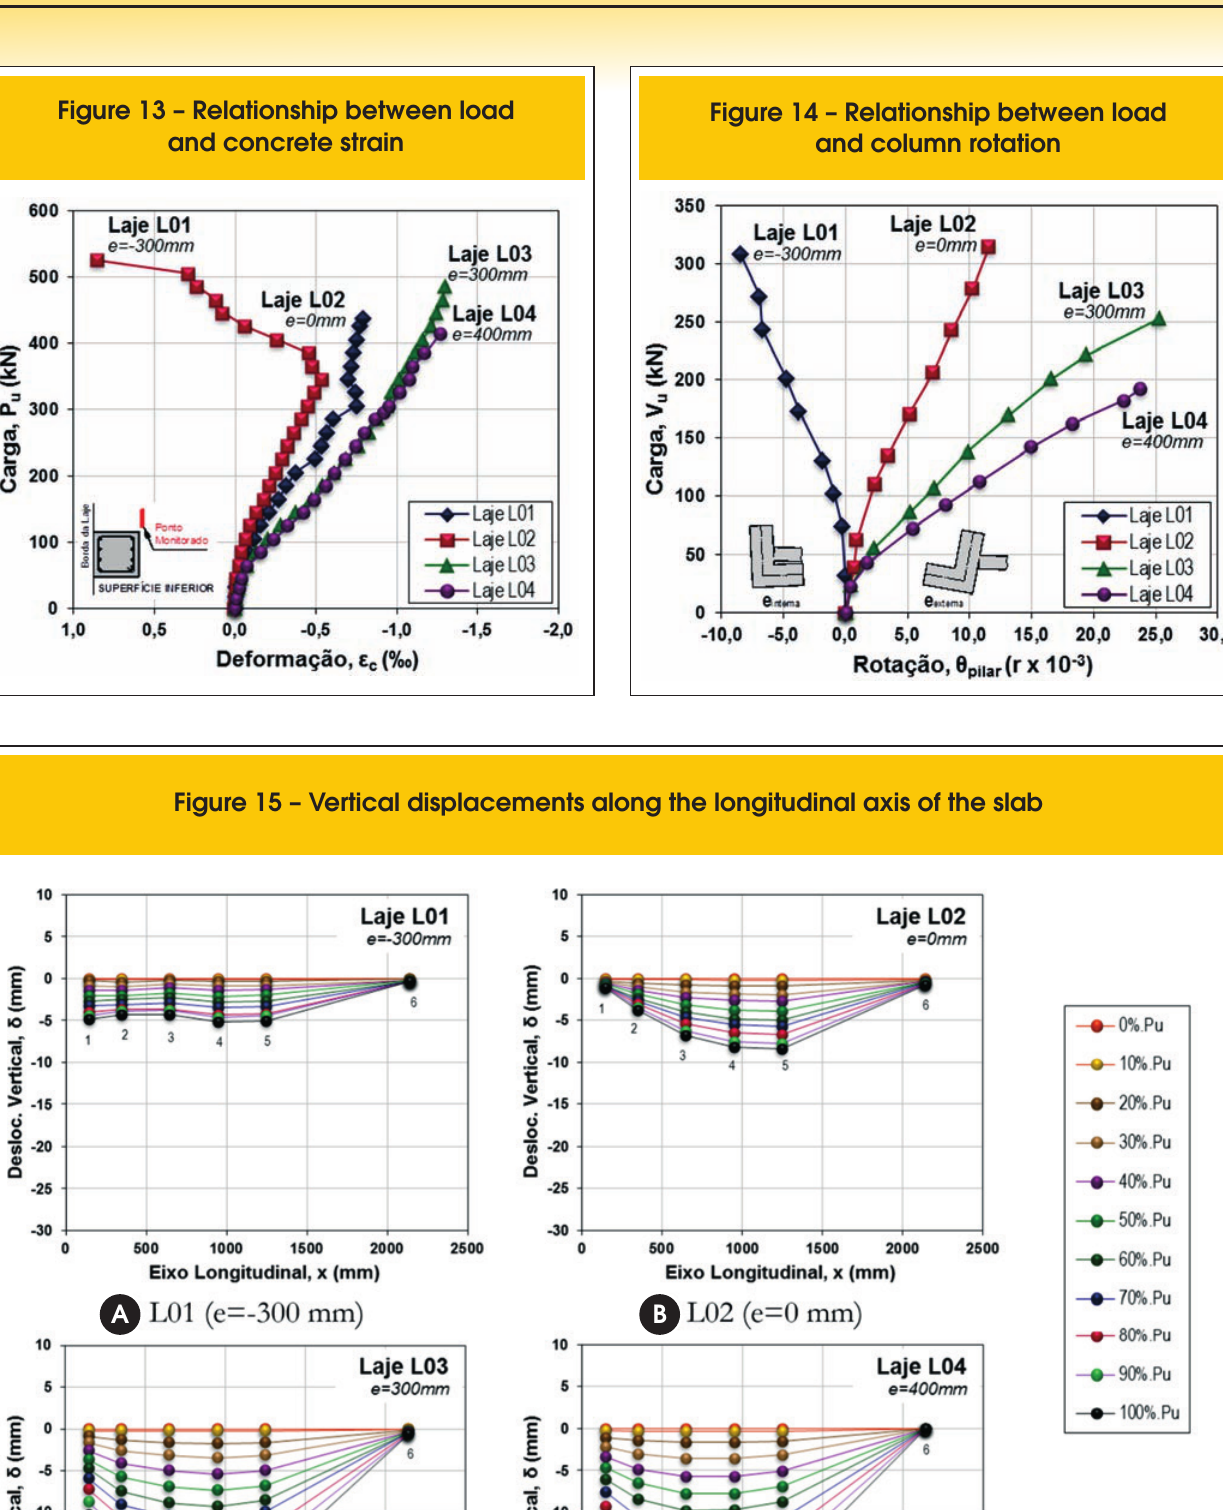
Figure 14 – Relationship between load and column rotation